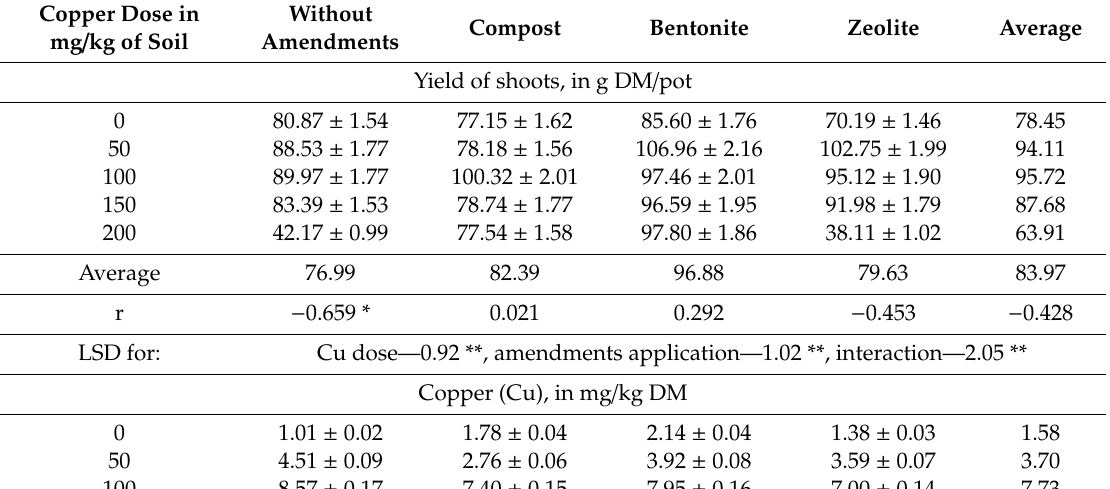
Table 3. E ff ect of copper contamination and amendments on yield of shoots and concentration of copper (Cu), zinc (Zn) and nickel (Ni) on shoots of maize ( Zea mays L.). Copper Dose